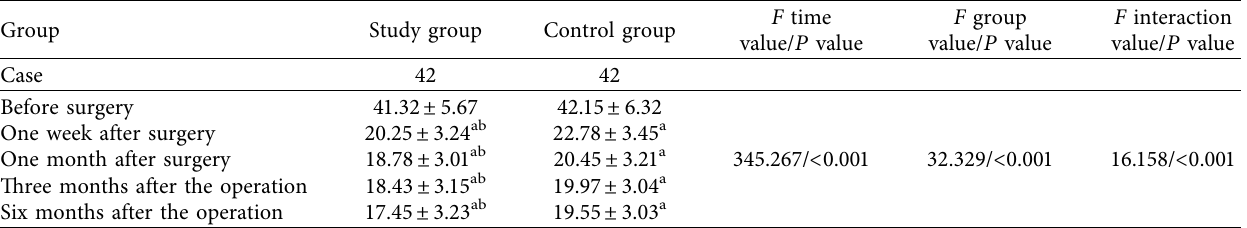
Table 1: Comparison of intraocular pressure at diferent time points in two groups (mmHg, x ± s